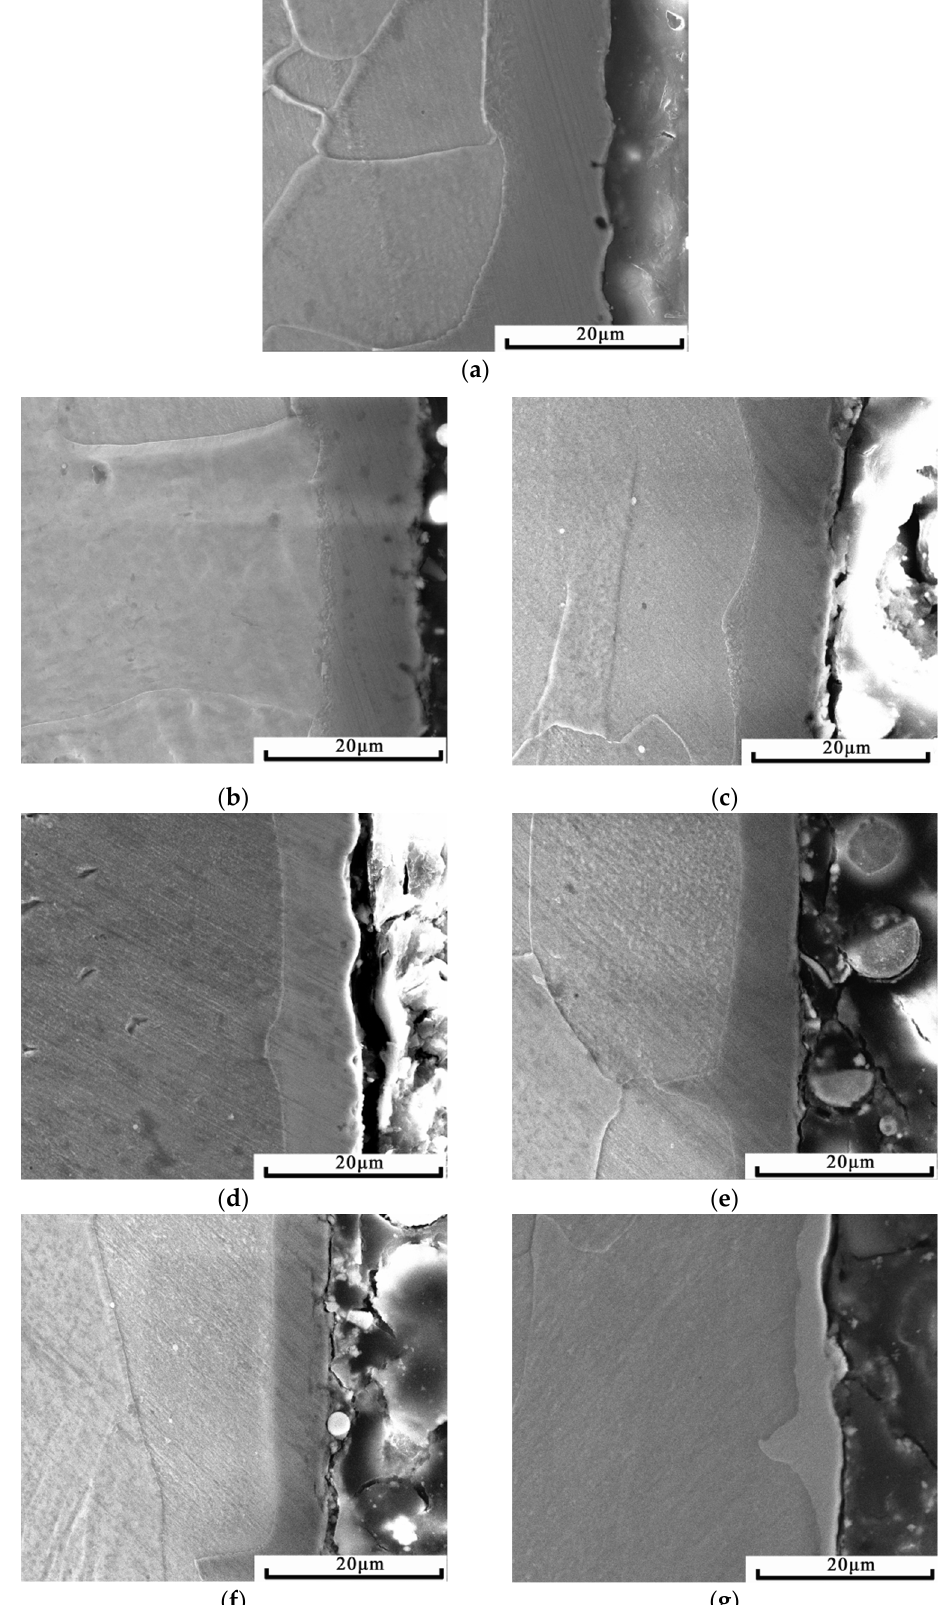
Figure 5. Cross-sectional morphology of each specimen: ( a ) original specimen; ( b ) 15% deformation; ( c ) 25% deformation; ( d ) 35% deformation; ( e ) 45% deformation; ( f ) 55% deformation; ( g ) 75% deformation.